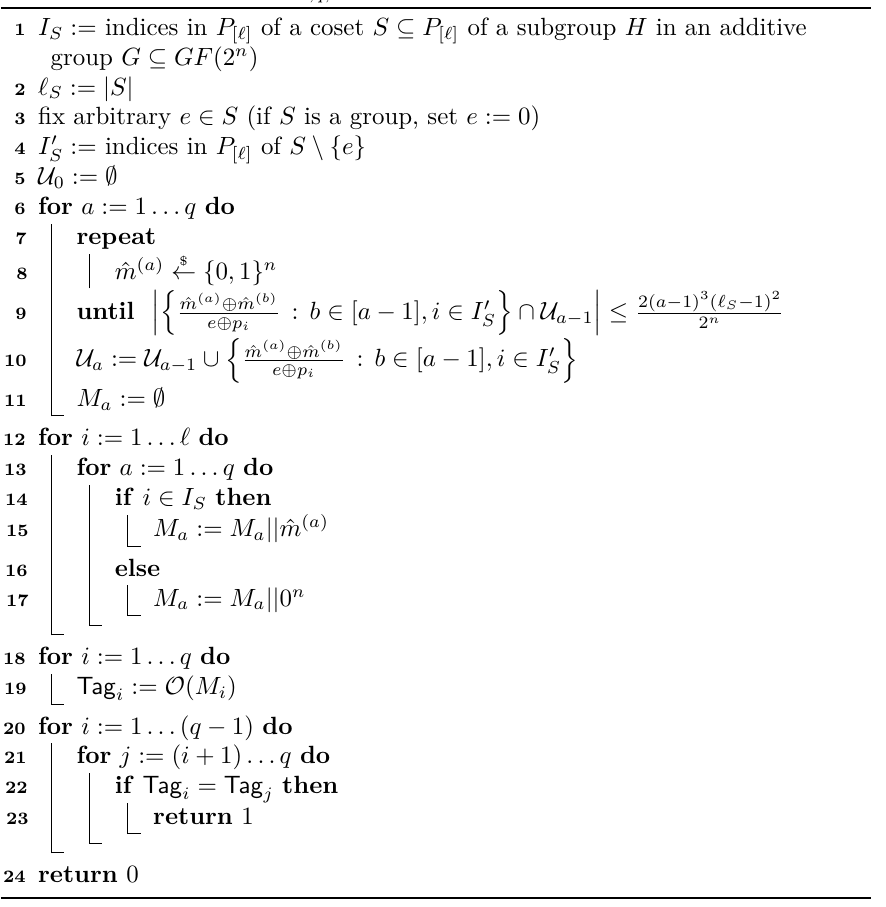
against PMAC , where P = ( p 1 , . . . , p 2 n − 1 ‘,q,n